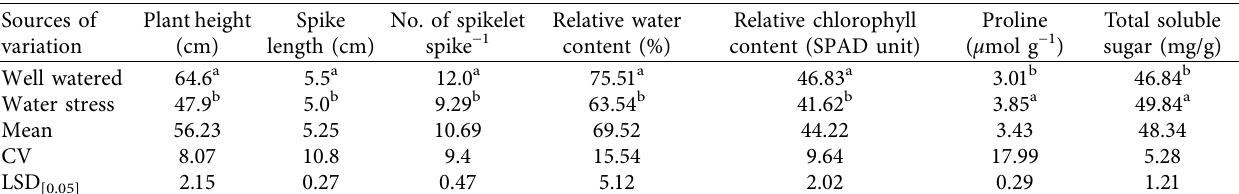
Table 4: Mean comparison of selected morphological, physiological and biochemical characteristics of wheat varieties under well-watered and water stress